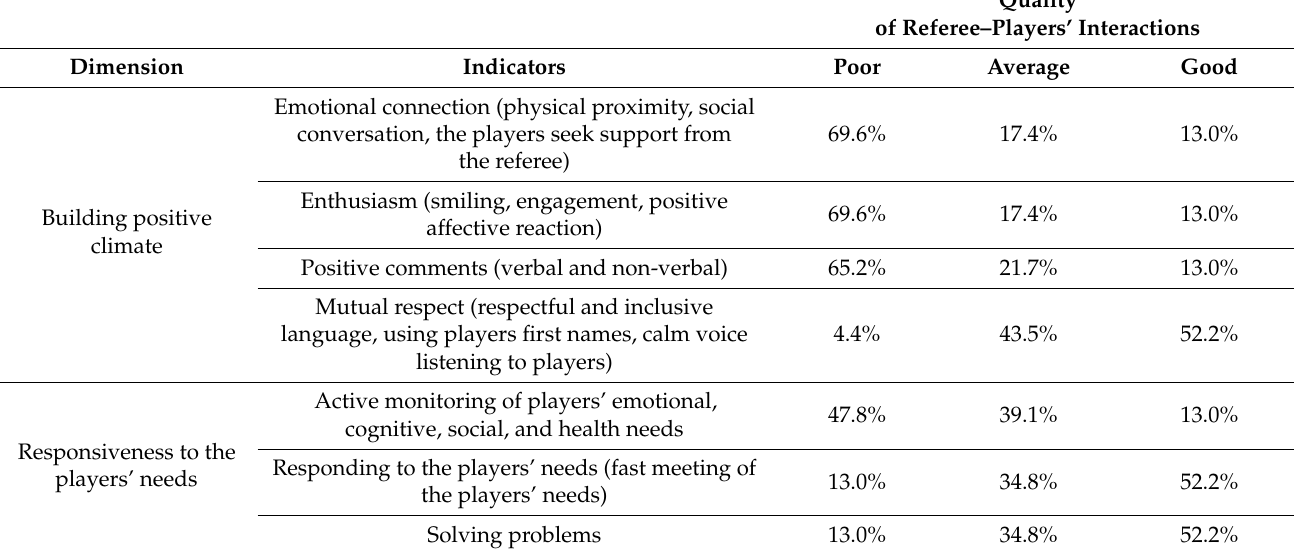
Table 4. Assessment the quality of referee–player interactions in the dimension of building a positive climate and responsiveness to players’ needs during children’s rugby competition ( n = 23).